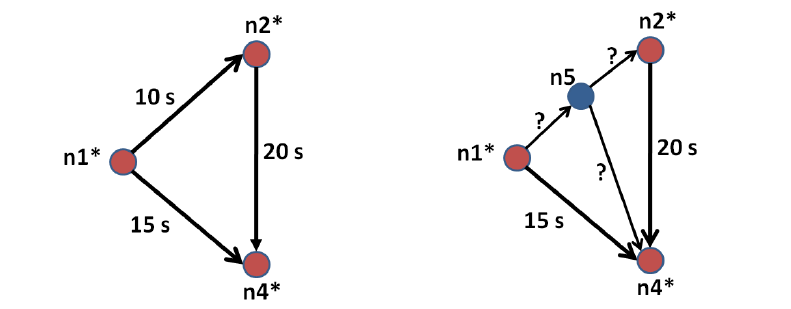
Figure 4. Calculation of the travel time of an arc of the detailed representation ( right ) from the aggregated representation ( left